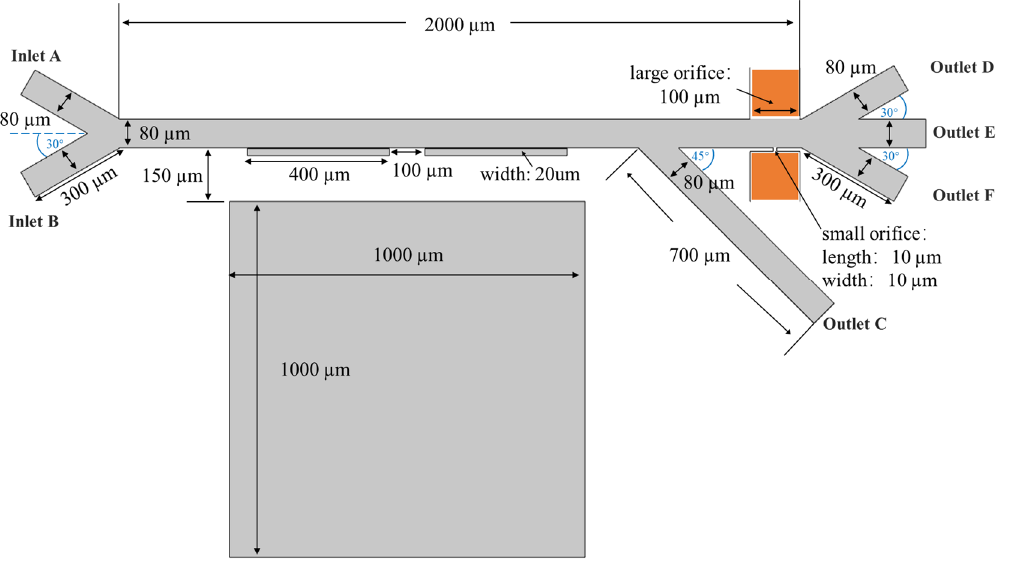
Figure 3. Schematic illustration of the integrated microchannel.